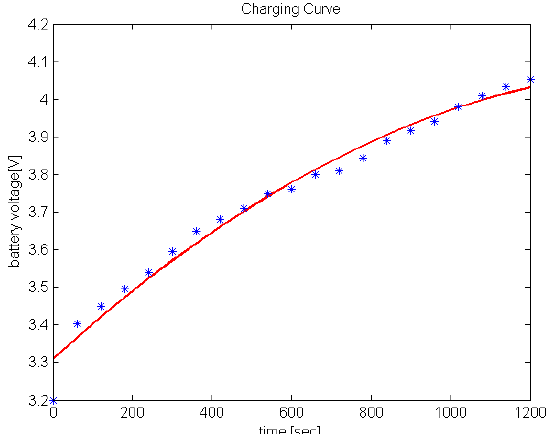
Figure 13. Typical charging curve using the wireless recharging